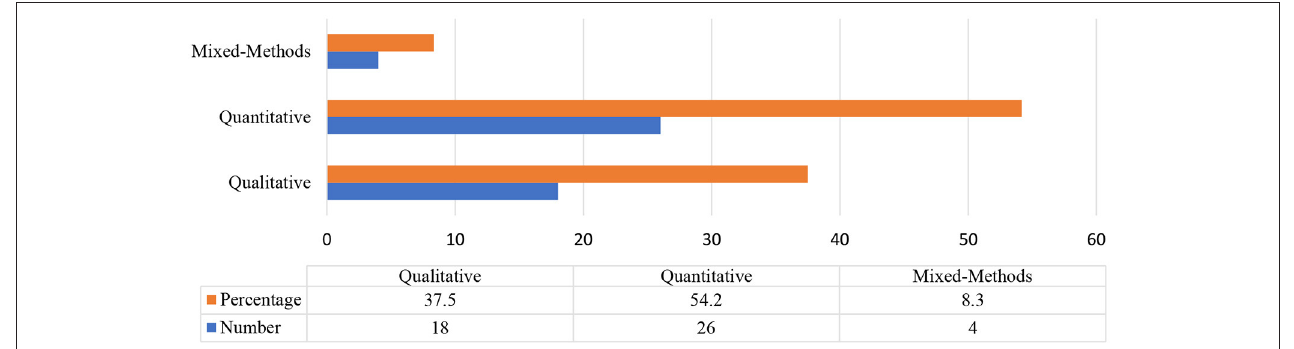
FIGURE 7 | Research designs employed in empirical emotioncy